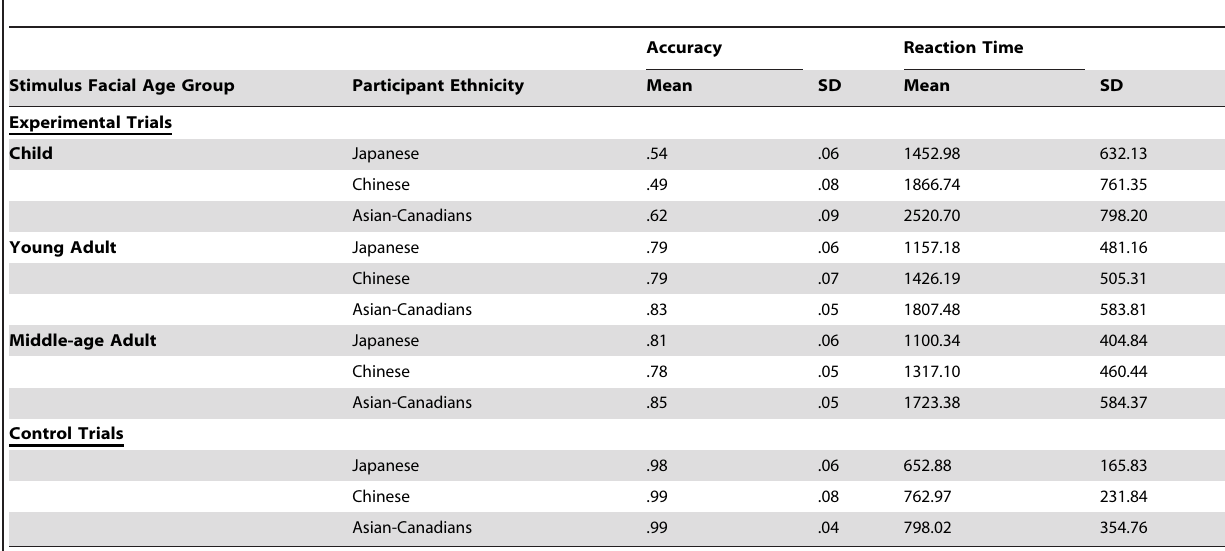
Figure 1. Stimulus set of Asian male faces. results revealed significant main effects of facial age, F (1, were significantly faster in their relative age judgments for young 112) = 263.49, p , .001, partial g 2 = .72, and participant ethnicity, and faster for middle-age adult than for young adult faces F (1, Table 1. Participants’ accuracy and reaction time scores in milliseconds for child, young adult, middle-age adult, and control facial age judgment trials (i.e., prior to adjustment for speed-accuracy tradeoffs).